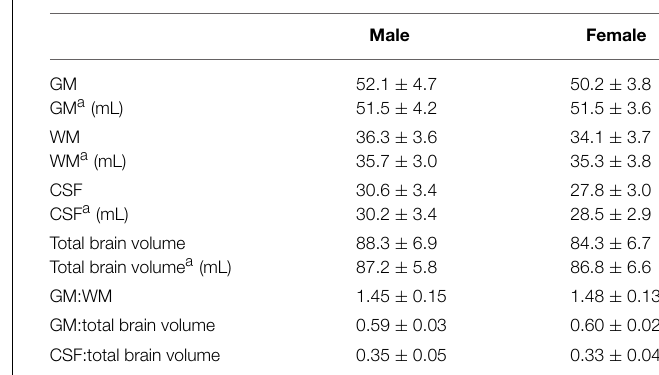
TABLE 4 | Brain tissue volume in mL (mean ± standard deviation) stratified for male and female sheep within the proof-of-principle study ( n = 38 ).